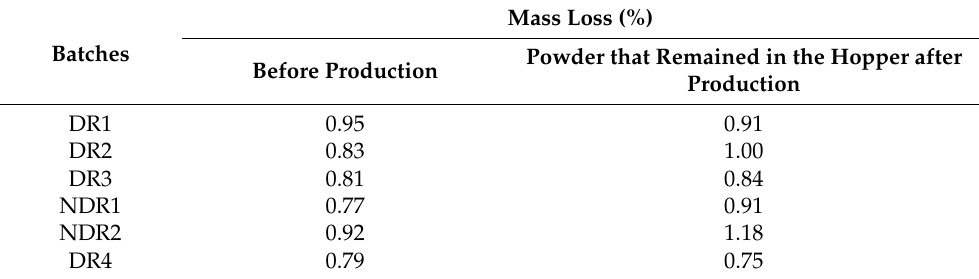
Figure 3. Thermal degradation profile of powders formulations before production. Table 5. Summary of mass losses in thermogravimetric analysis (TGA) from ambient temperature to 115 °C. Batches